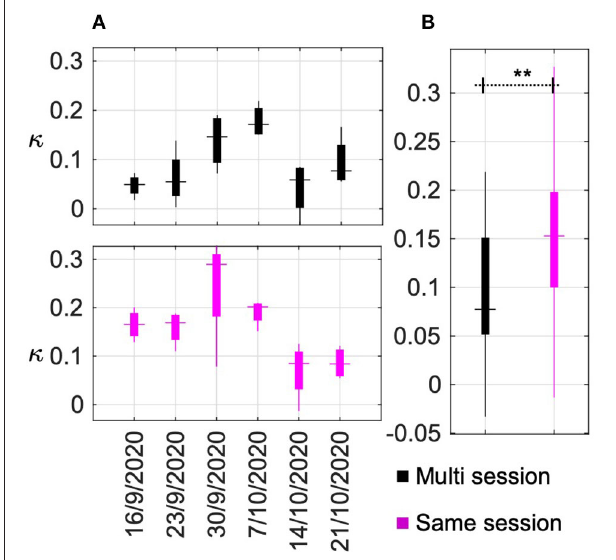
six sessions in phase III using “multi-session” and “same-session” models. Each box corresponds to the performance across the four game runs in each session. The horizontal dash indicates the median value, the top and bottom edges of the box indicate the 25th and 75th percentiles and the vertical line indicates the range. (B) Summary of the overall performance across all game sessions in phase III for the “multi-session” and “same-session” models. Columns marked with ** imply statistically significant difference with p <